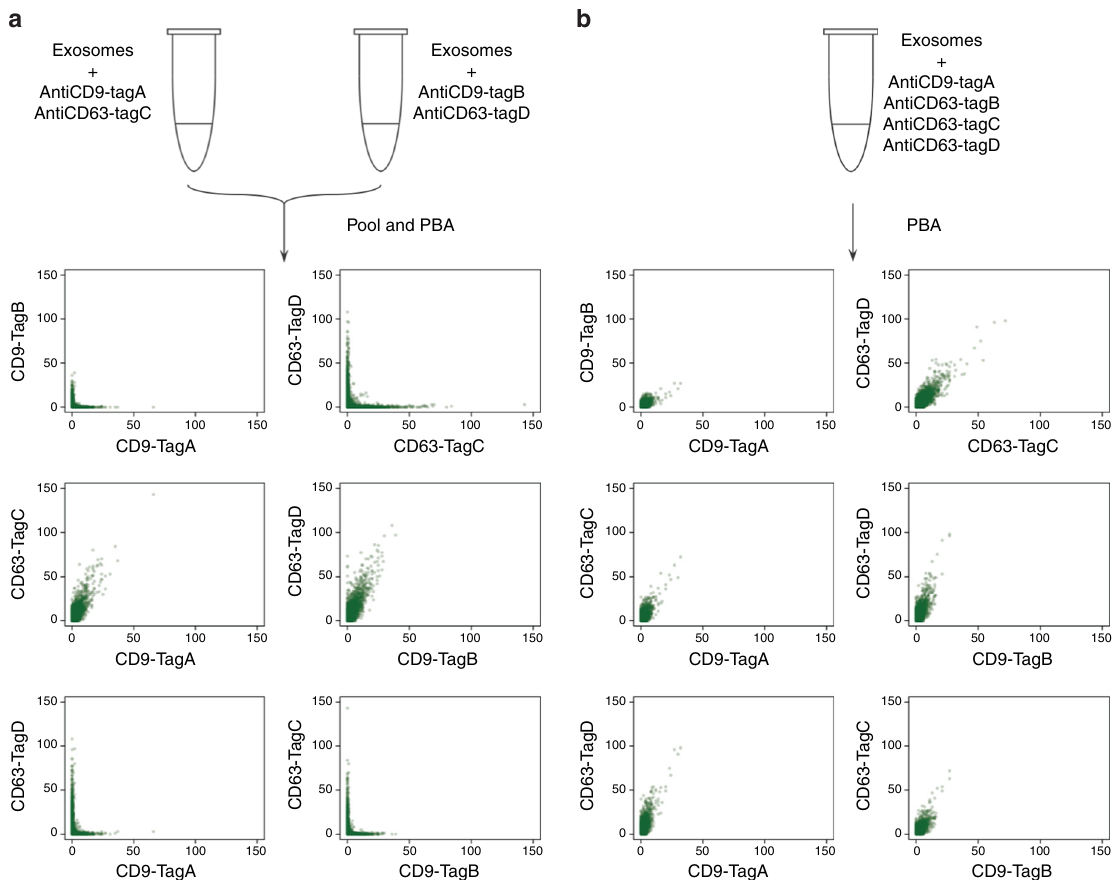
Fig. 3 Validation of PBA on exosomes using antibodies to CD9 and CD63. a Separate incubation: exosomes isolated from the K562 cell line were incubated with two distinct sets of PBA probes separately before they were pooled for PBA. b Mixed incubation: exosomes were incubated with four different